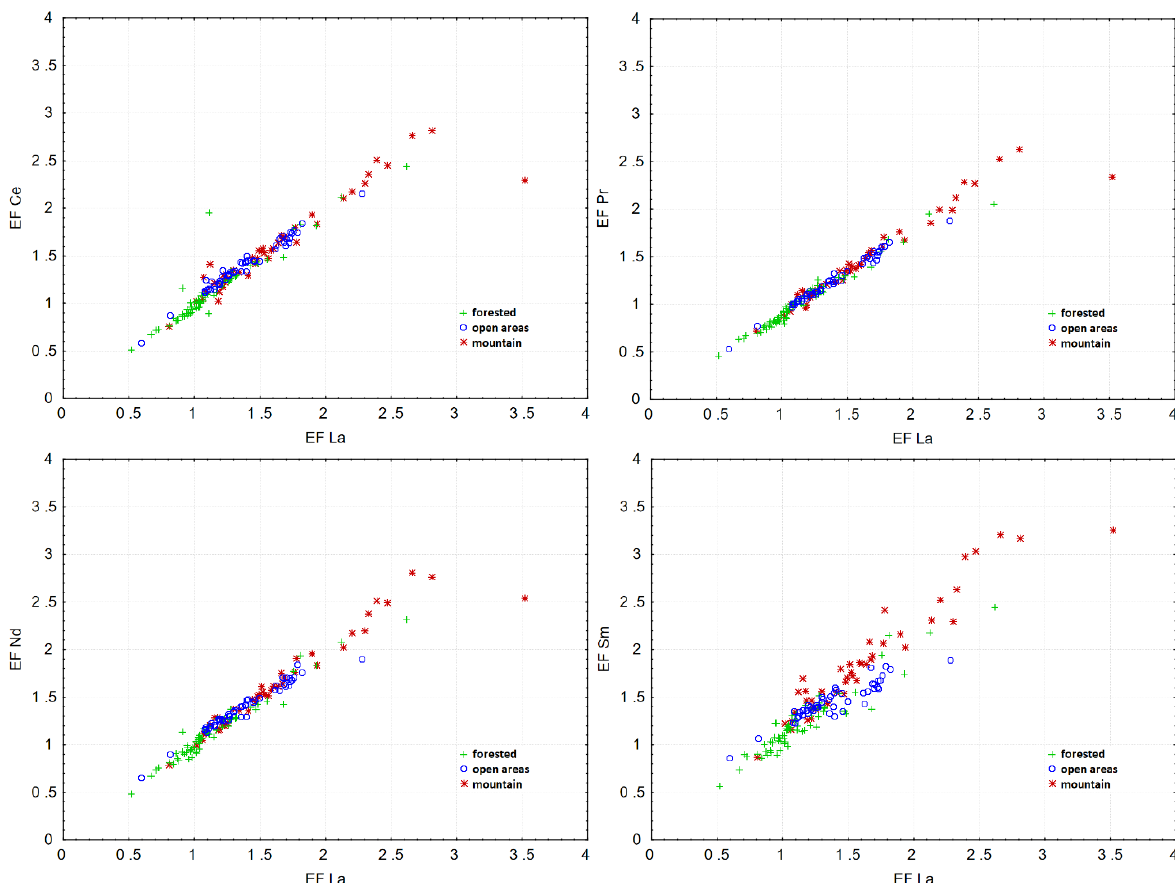
Figure 4. Scatterplots of ratios EF La to: EF Ce, EF Pr, EF Nd and EF Sm for forested, open, and mountain areas; the points on the scatterplots were marked depending on the area, where the measurements was taken: forested areas by crosses (USIA forest 1, 2, and 3), open areas by circles (USIA open 1 and 2), and mountain areas by stars (Izera open and Izera forest).